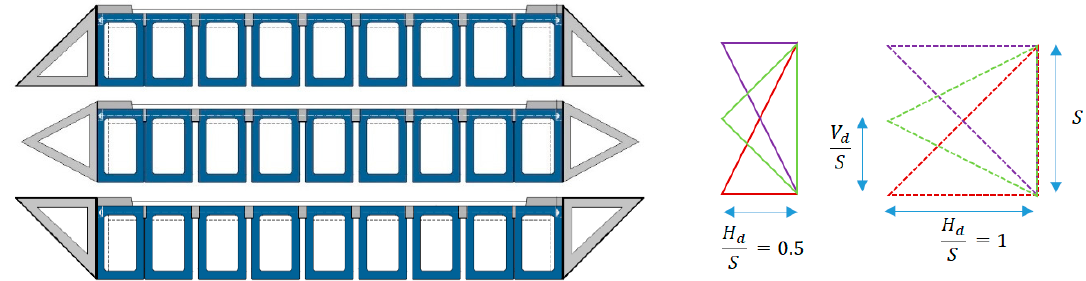
Figure 26. Schematic shape of the deck using end caps for flood force mitigating effect. Displayed on the left are Scenario 6 ( top ), Scenario 5 ( middle ), and Scenario 4 ( bottom ). Table 7. Dimensions of the end caps.